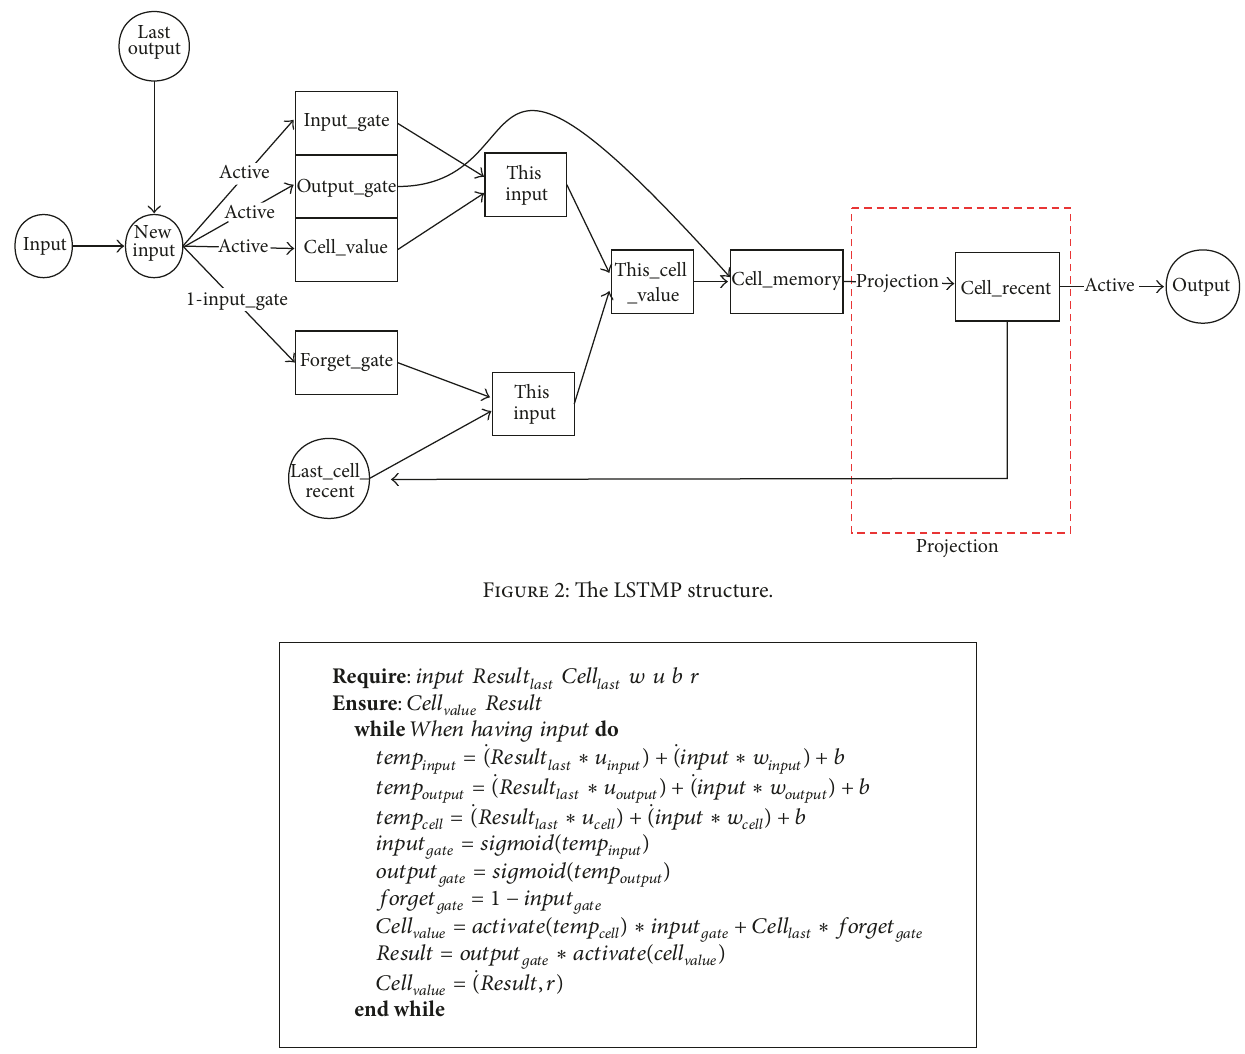
Figure 2: The LSTMP structure.